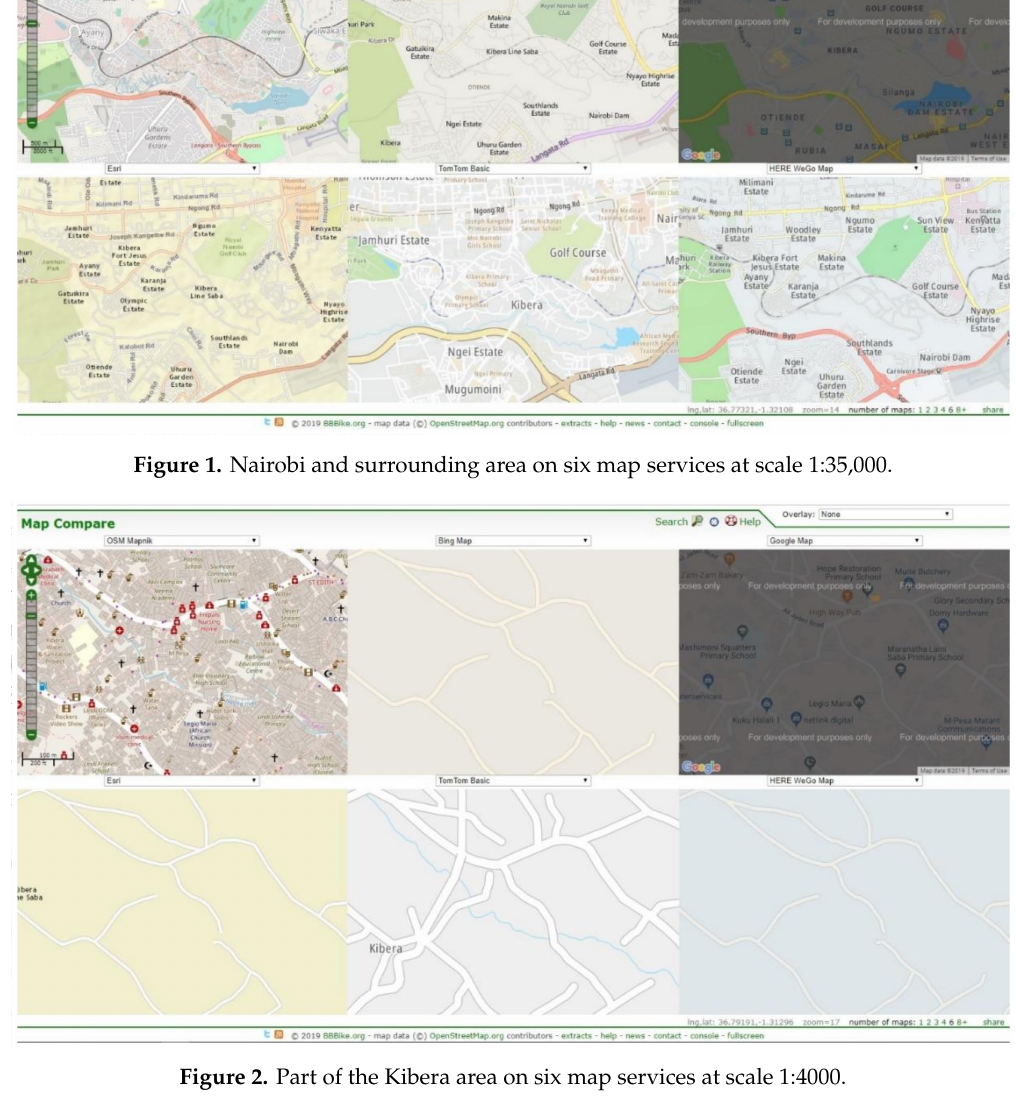
Figure 2. Part of the Kibera area on six map services at scale